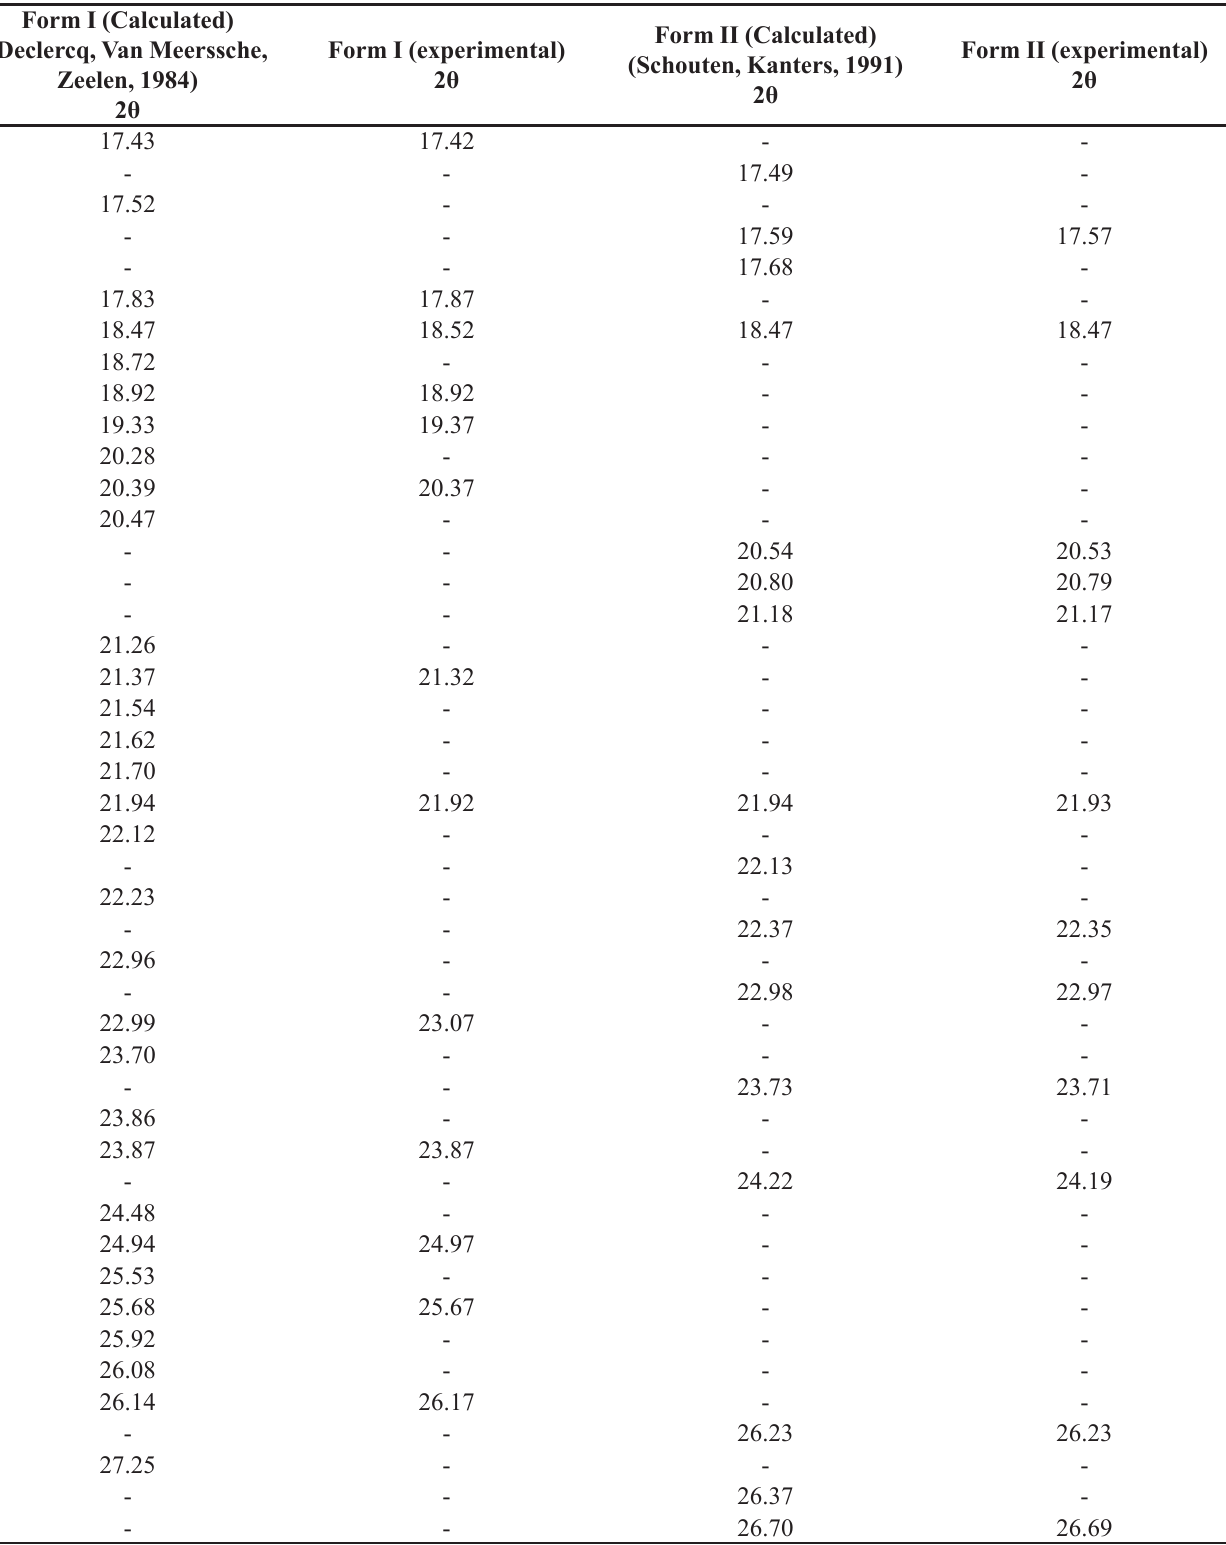
)) from simulated patterns of tibolone forms I and II in comparison K a